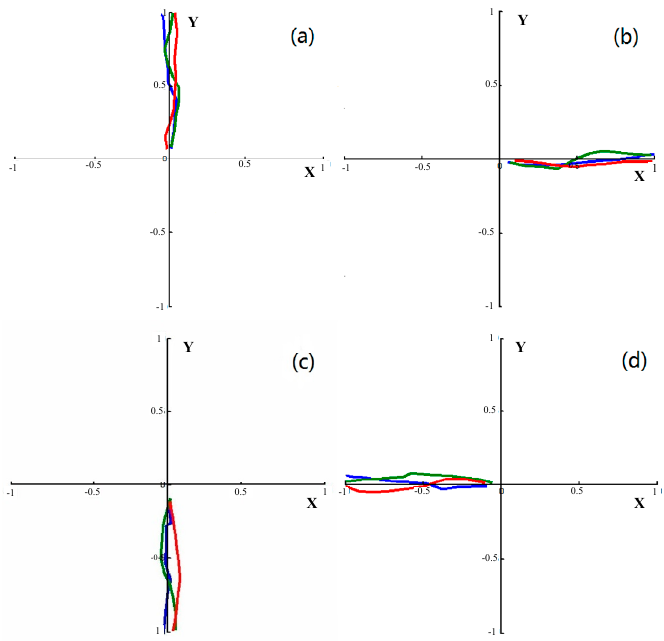
Figure 14. Normalized continuous trajectories of robotic arm moving towards target A ( a ), target B ( b ), target C ( c ), and target D ( d ) controlled by movement imagination EEG signals from subject 1.